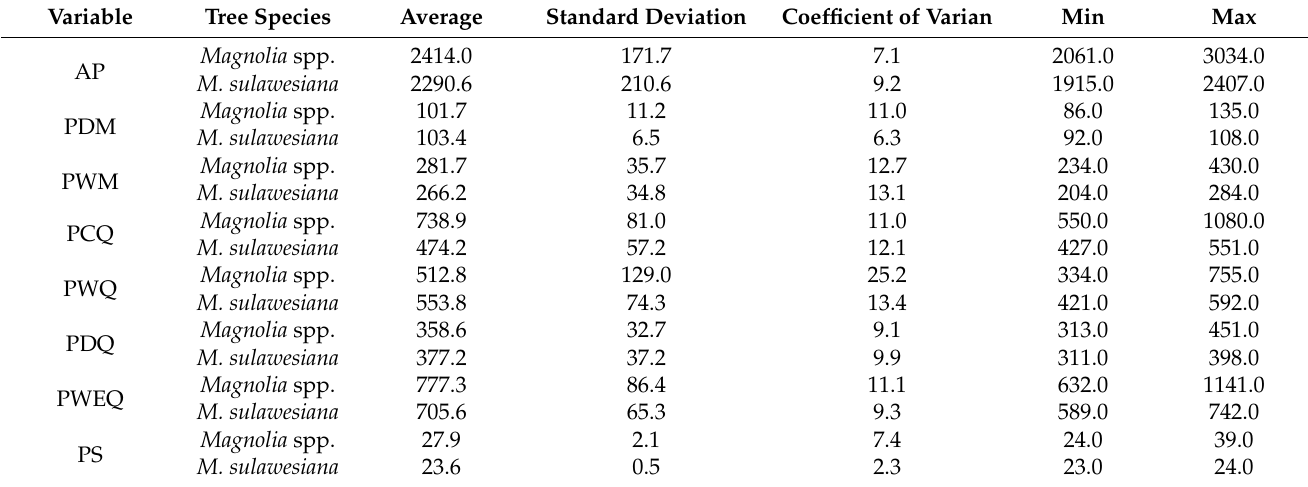
Table 5. Statistical descriptions for precipitation indicators.